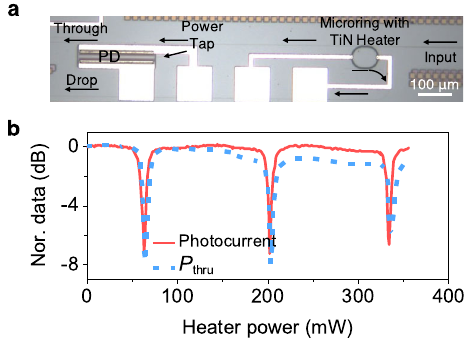
Fig. 3 | On-chip characterization of a racetrack microring fi lter using an inte- grated PD. a An optical micrograph of the PIC consisting of a thermally tunable microring with a PD connected to the power tap at the through output port. b Normalized photocurrent and through port transmission, P thru , as a function of the TiN heater